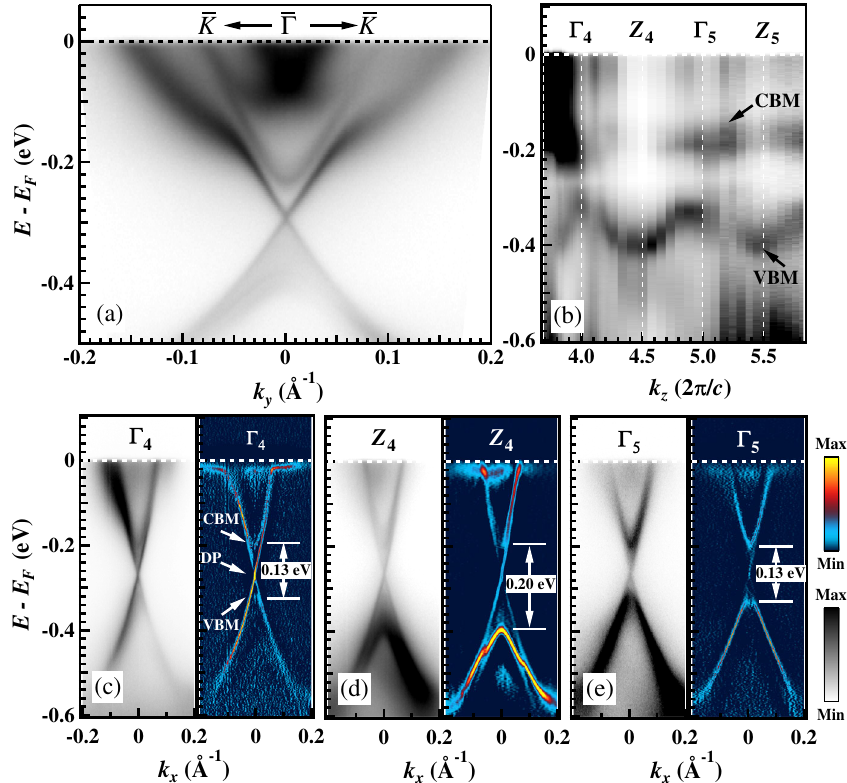
¯ Γ ¯ K ¯ K FIG. 2. Surface and bulk electronic structure of MnBi 2 Te 4 . (a) A typical ARPES k - E map along - - ( k ), taken at 10 K under y photon energy h ν ¼ 6 . 3 eV. A linear, X-shaped, gapless state exists between the valence and the conduction bands. The Dirac point ¯ Γ ¼ 288 meV for this sample. (b) k (DP) energy locates at E dispersion map at , taken with 6 – 20 eV photons. VBM, valence band D z maxima; CBM, conduction band minima. Periodic dispersion pattern on the VBM is seen clearly. The bulk Γ and Z points are determined by assigning an inner potential V 0 ¼ 9 eV, estimated from the total bandwidth of the valence bands. (c) – (e) k - E maps along ¯ Γ ¯ M ¯ M - - ( k ) taken at the Γ 4 , Z 4 , and Γ 5 points marked in (b) (corresponding to h ν ¼ 7 . 5 , 10.5, and 13.5 eV, respectively). It is clear that x the gapless state forming the Dirac cone has no k dispersion, while the VBM evolves from − 0 . 33 eV ( Γ ) to − 0 . 4 eV ( Z ), consequently z changing the bulk gap from 0.13 to 0.20 eV.